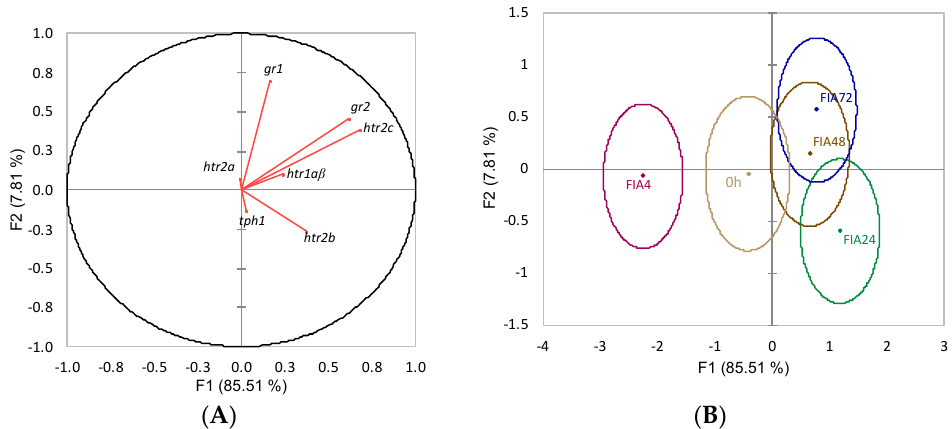
( gr2 , B ) in undisturbed European seabass (0 h, ) or i.p.-injected with a sham solution (CTRL, □ ) or Freund’s Incomplete Adjuvant (FIA, ■ ) and sampled at 4, 24, 48, 72 h post-injection (means ± SD, n = 8). Different symbols (* and #) stand for significant differences between i.p.-injected groups and the undisturbed group (0 h). Capital letters stand for significant differences between stimuli. Lower- case letters indicate significant differences between sampling times. Further details in legend of Figure 1.